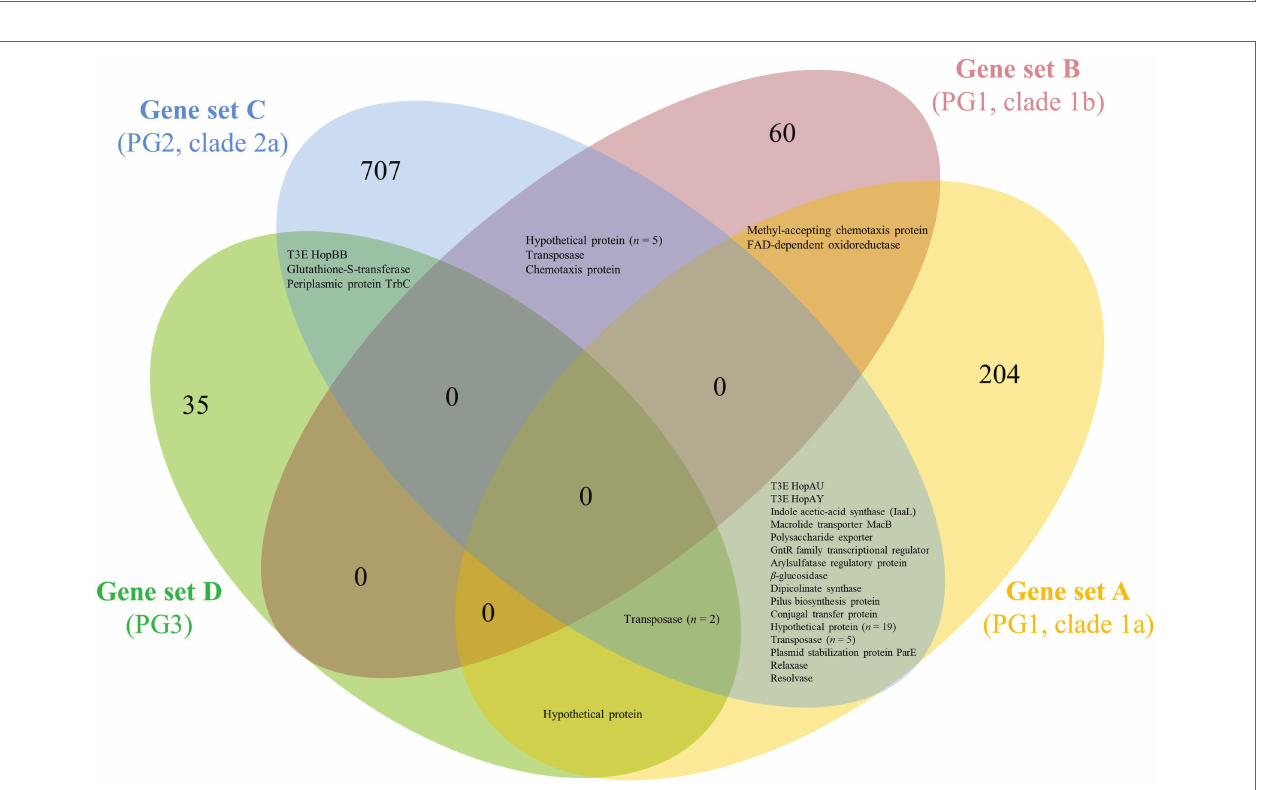
FIGURE 1 | the orthology criteria of EDGAR 2.2. Proteins highlighted in pink are involved in virulence based on their annotation. Protein descriptions followed by two asterisks (**) indicate that orthologs were also found using online TBLASTN analysis against 13 additional Pseudomonas species closely related to the P. syringae species complex as reported in Supplementary Figure 4 . The proteins are ordered by decreasing significance of the likelihood ratio (LR) statistic when exceeding the p ≤ 0.05 threshold of 5.36. This order is not indicative of any physical proximity. Locus tags and LR statistic are reported over each considered protein; h.p.: hypothetical protein; NA: not applicable; and ND: not determined.